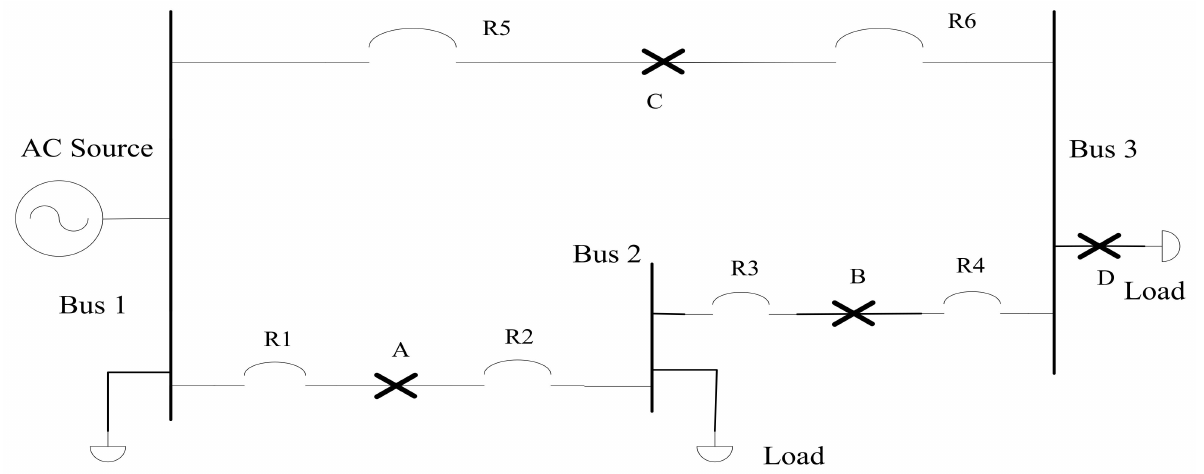
Figure 12. A multi-loop distribution power system (Case 4). Table 11. Plug settings (PS) and CT ratios of the relays (Case 4). Faulty Point